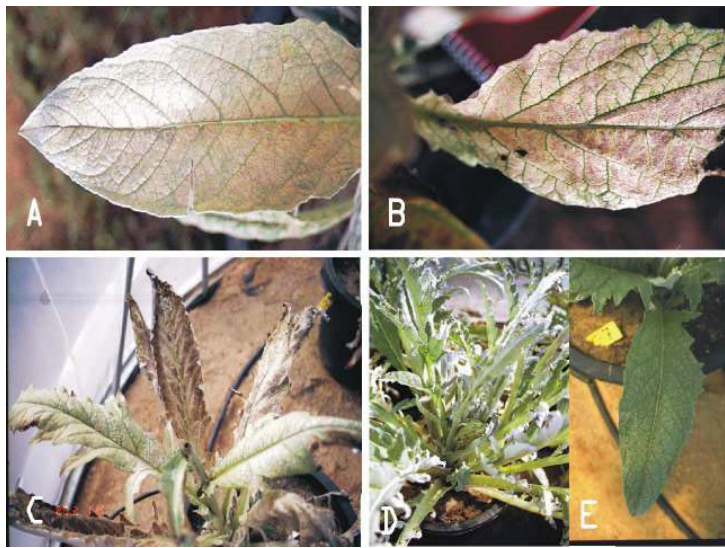
FIGURE 3 . (A) Artichoke leaf with developing visual ozone injury; symptoms appeared in the upper part of older leaves. (B) Leaf strongly affected. (C) General view of fumigated plant. (D)